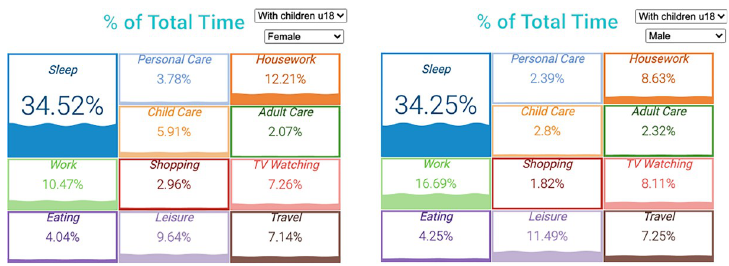
Fig 5. Percent of total time spent on select activities among women (left) and men (right) sandwich caregivers. Source: IPUMS ATUS Extractor: Sample of self-identified family caregivers from